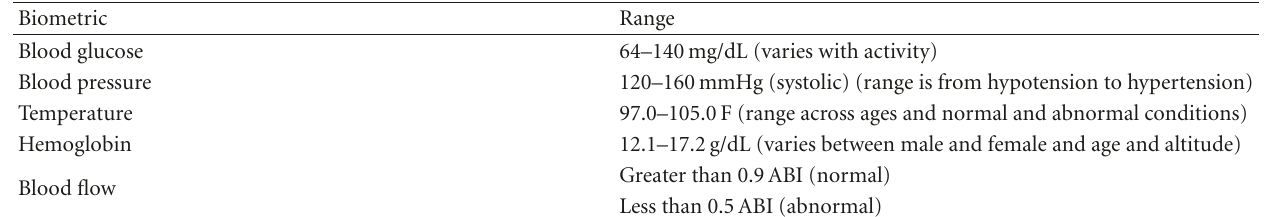
Table 2: Candidate biometrics with their